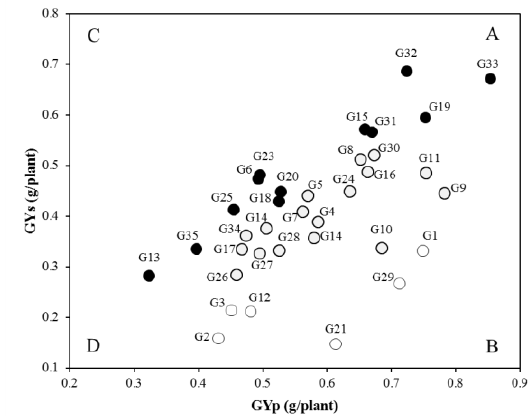
produced under non-stress (GYp) and zinc deficit stress (GYs) conditions in 35 durum wheat genotypes. The G6, G13, G15, G18, G19, G20, G23, G25, G31, G32, G33, and G35 genotypes which are Zn-efficient genotypes (black circles) and also G1, G2, G3, G12, G21, and G29 which are Zn-inefficient genotypes (white circles). The numbers inside the figure are genotypes code (see Table 1).